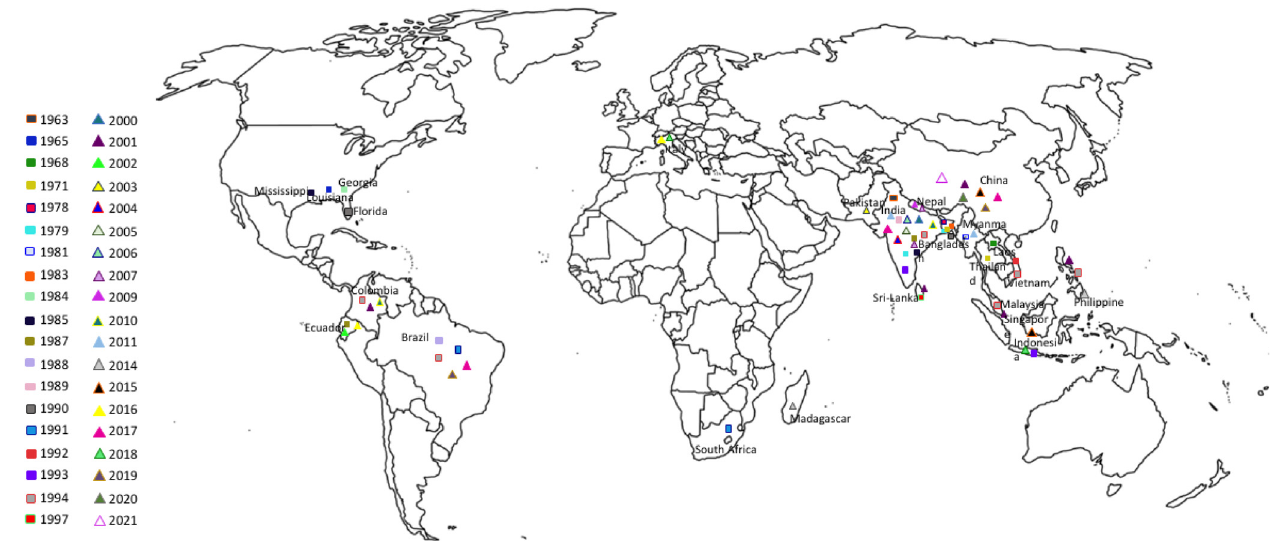
Figure 1. Geographical distribution of Meloidogyne graminicola.